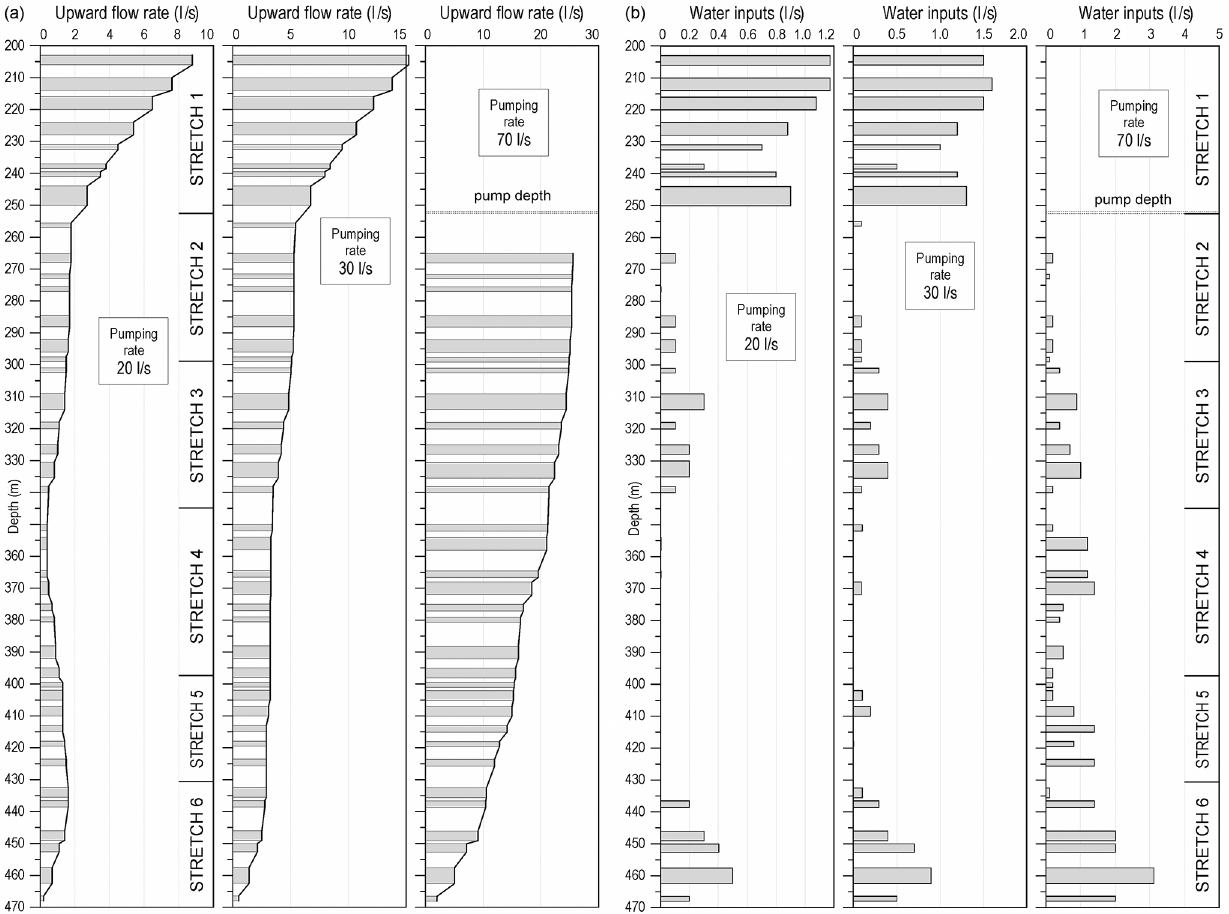
Figure 9. Flowmeter results in the case study (grey horizontal bars reflect the depth intervals of each screen). (a) Upward flow rate versus depth; (b) water inputs from each screen.